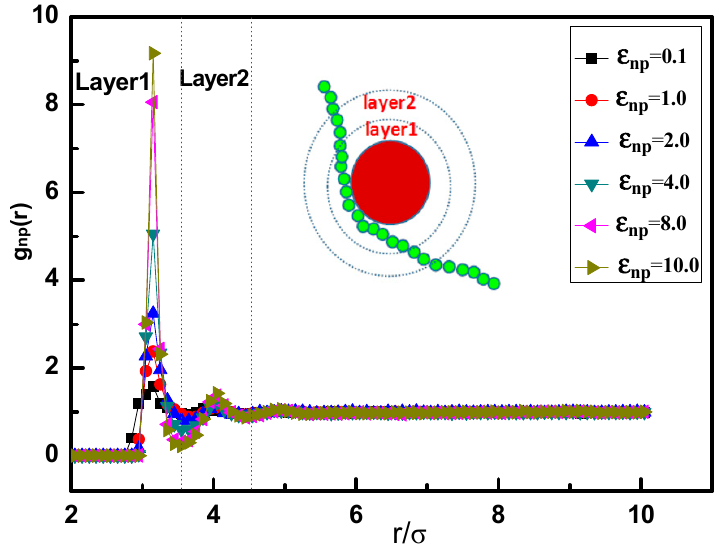
Figure 1. Polymer-nanoparticle (NP) pair distribution function g np ( r ) in nanocomposites for various attractive interactions ε np .